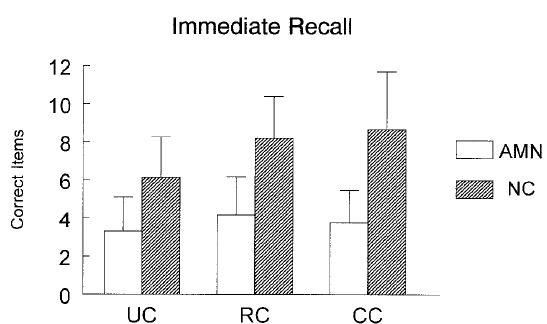
Fig. 1. Mean total scores (and SDs) for immediate recall in amnesic (AMN) and control participants (NC) (UC = uncategorised list, RC = random categories, CC = consecutive